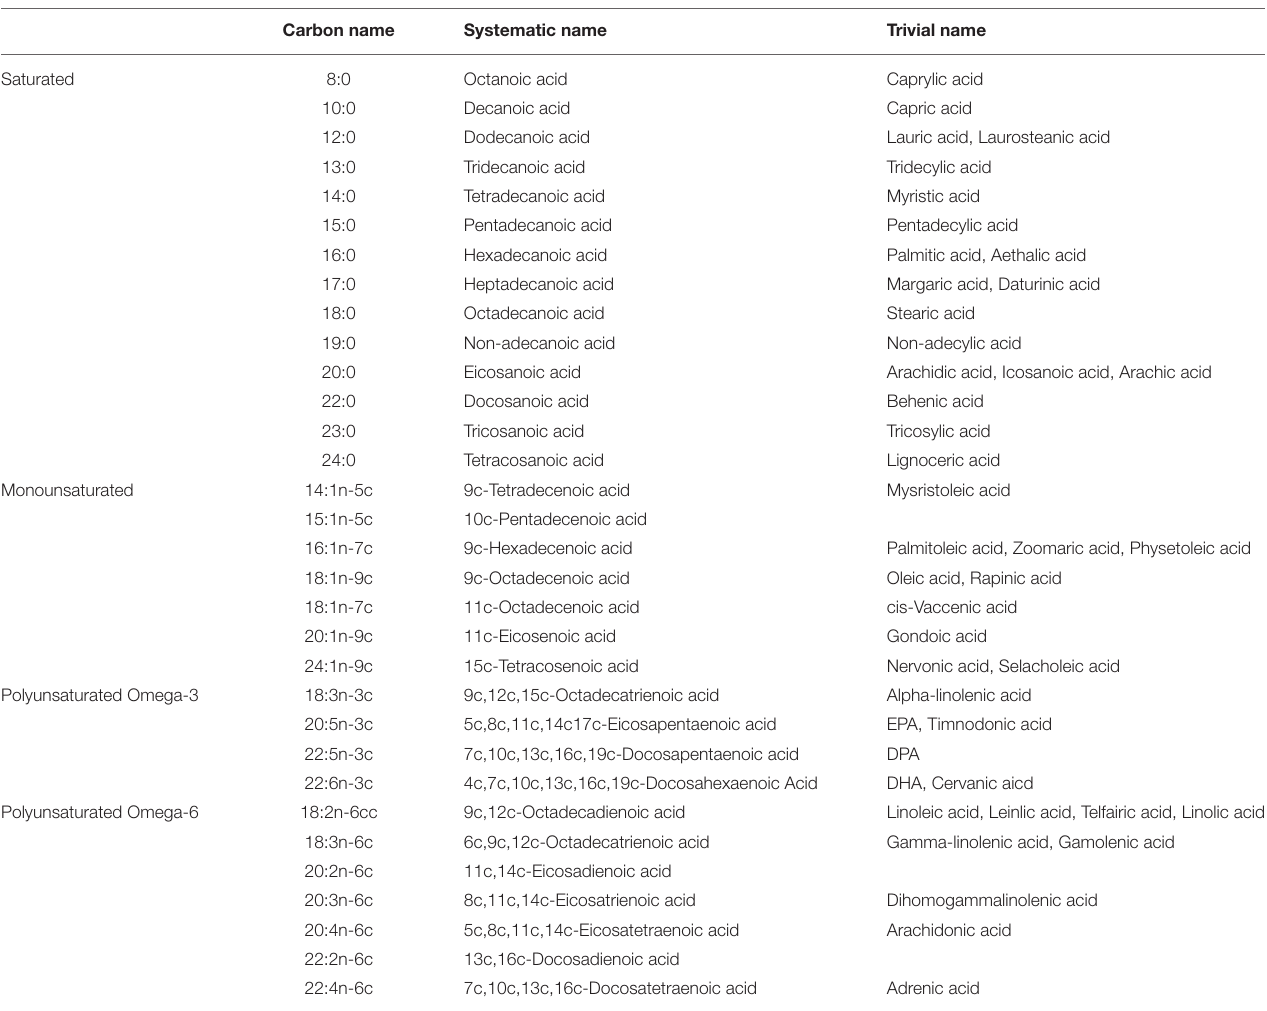
TABLE 1 | Fatty acids quantified in serum